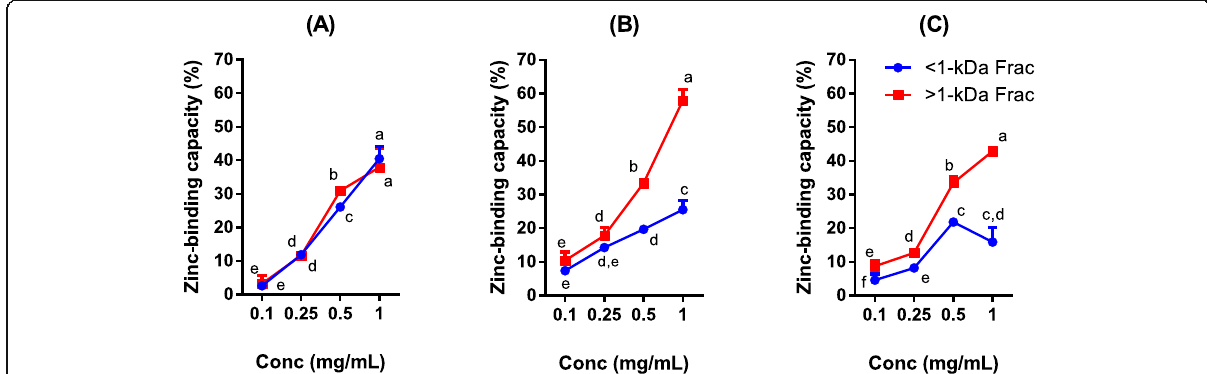
Fig. 2 Zinc-binding capacity of whey protein hydrolysate (WPH) fractions of molecular weight ranges < 1 kDa and > 1 kDa: ( a ) WPH-Esp, WPH produced with Esperase, ( b ) WPH-Ever, WPH produced with Everlase; and ( c ) WPH-Sav, WPH produced with Savinase. Data points with different letters are significantly different mean values ( P < 0.05)